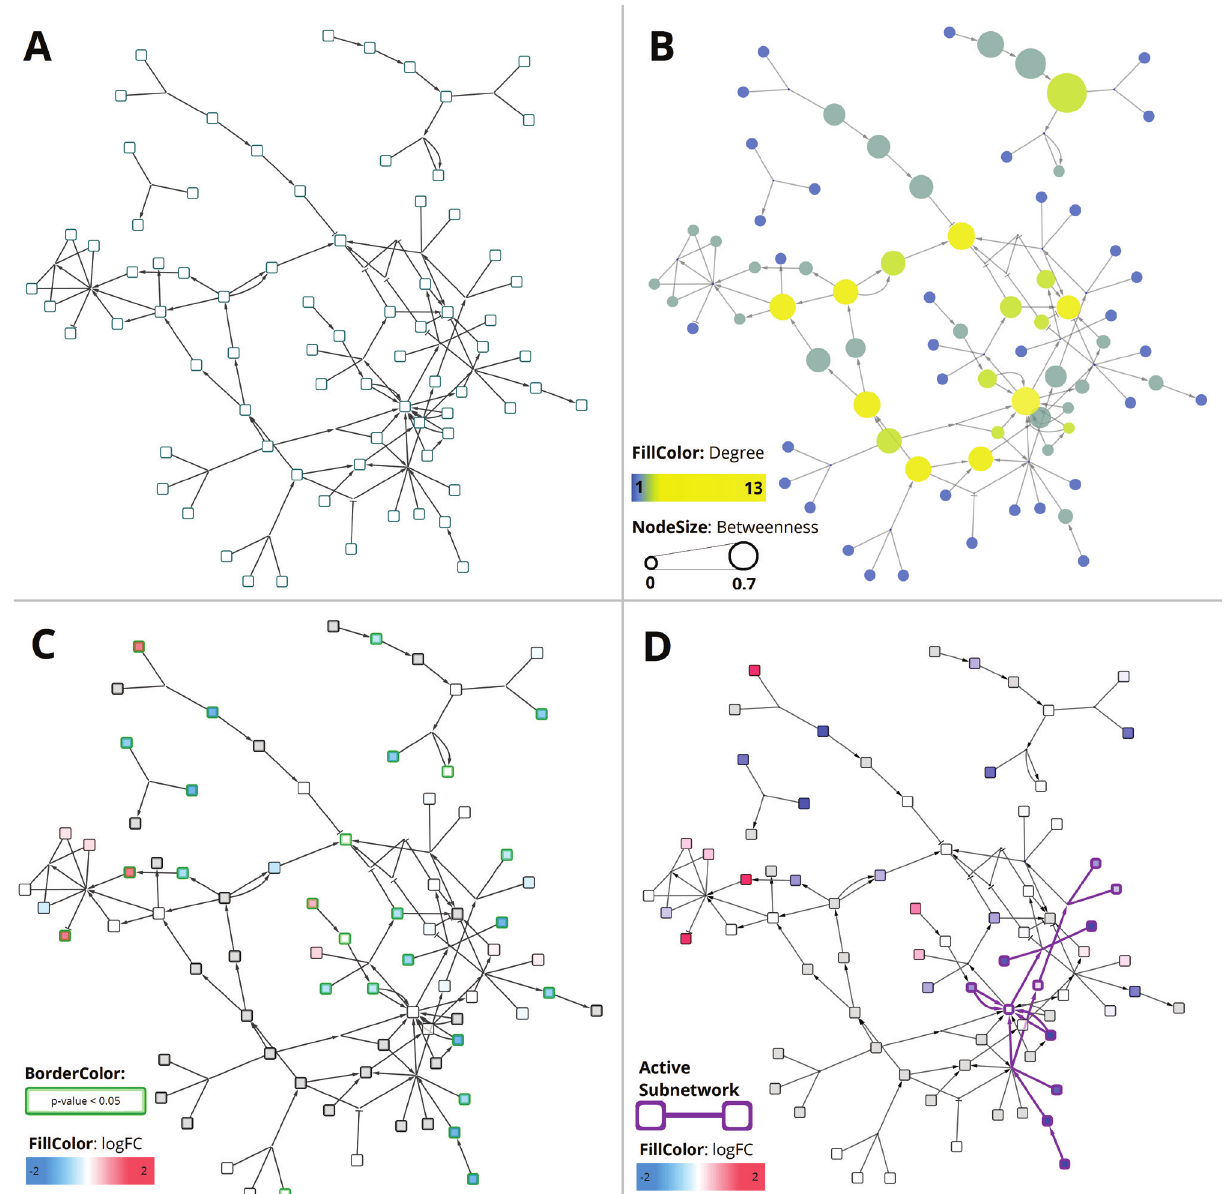
Figure 2. The Cardiac Hypertrophic Response pathway loaded as a network. ( A ) The simple network does not contain graphical annotations of the pathway. ( B ) NetworkAnalyzer was used to visualize node degree and betweenness of the nodes in the network to identify important hub nodes. ( C ) The logFC of the example dataset is visualized as node fill color with a gradient (blue over white to red) and the adjusted p-value < 0.05 is highlighted with a green border color. ( D ) jActiveModules finds active subnetworks (highlighted in purple) that are affected by varying gene